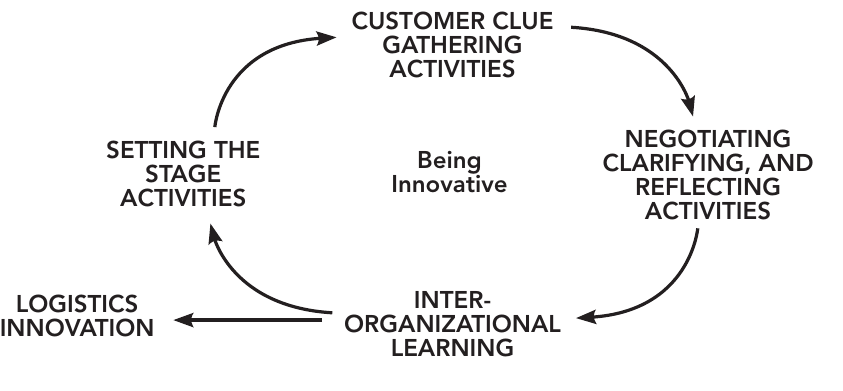
Figure 1: A logistics innovation process (Flint et al ., 2005: